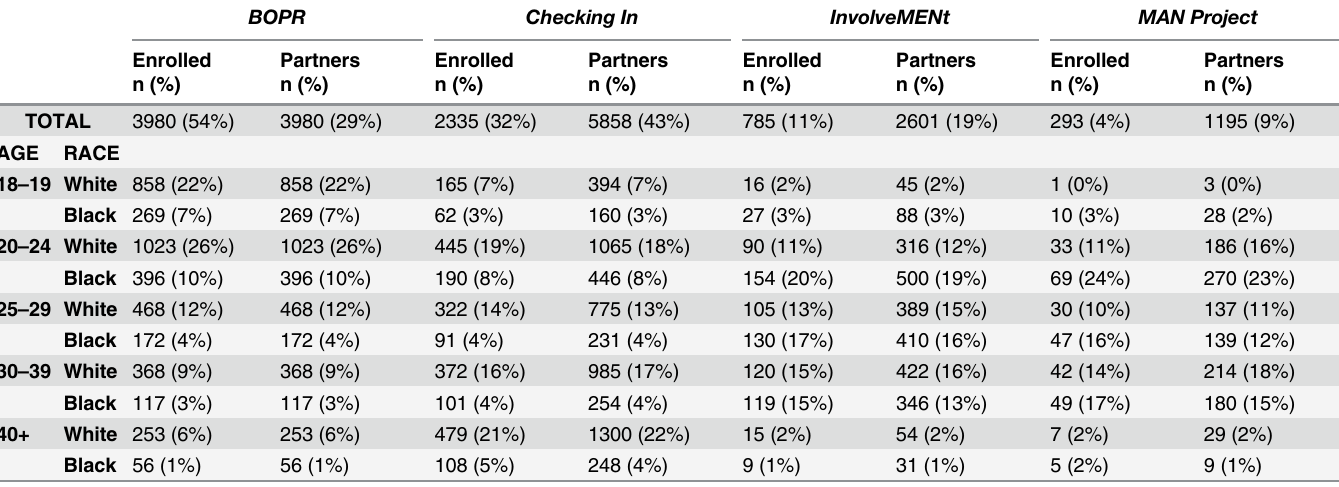
Note : Percentages for the total row are row percentages across studies (e.g., percentage of enrolled participants from the BOPR study out of all enrolled participants). The remaining percentages in the table are column percentages within study (e.g., percentage of partners reported by Black MSM aged 18 – 19 out of all partners reported in a given